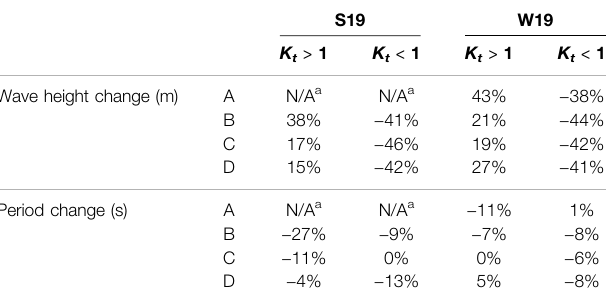
TABLE 3 | Average change in signi fi cant wave height and wave period between the incident and transmitted wave heights at Sites A, B, C, and D. Negative percentages indicate a decrease of period or wave height of the transmitted wave as compared to the incident wave.